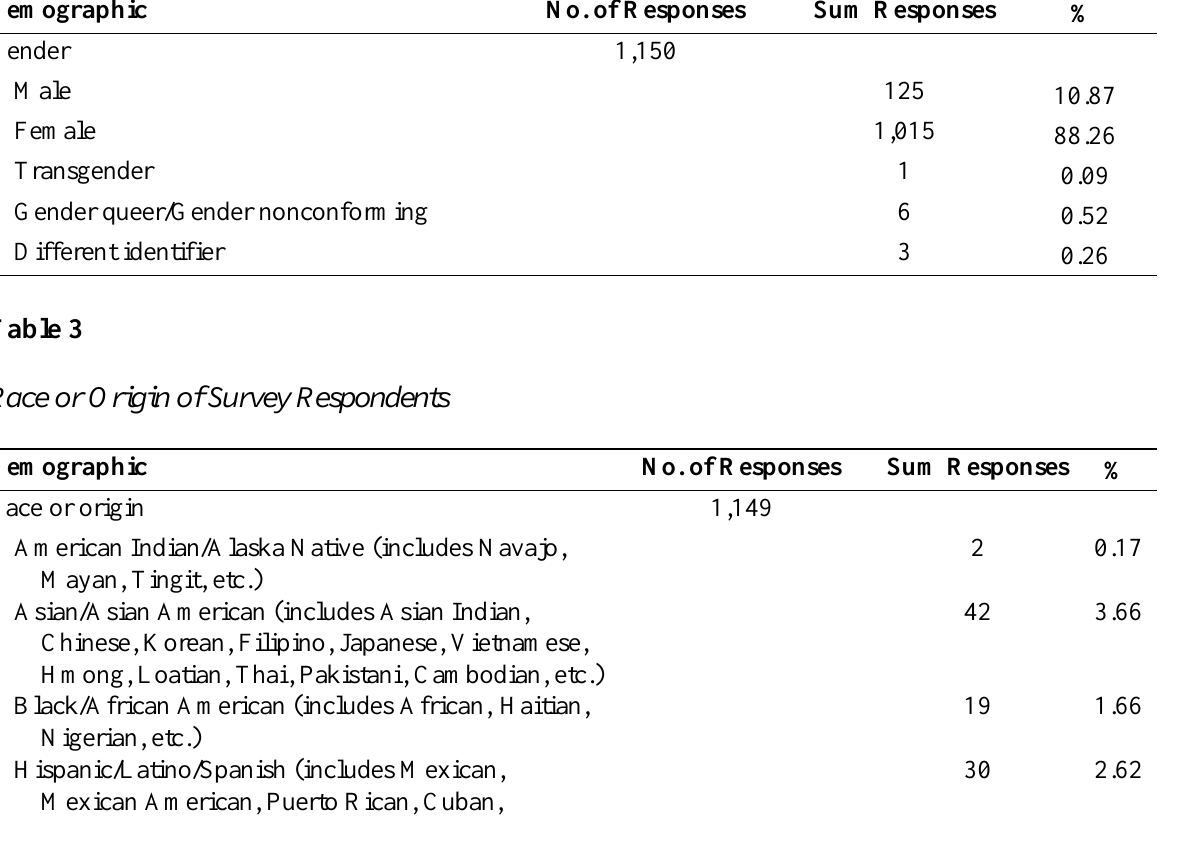
Gender/Gender Identity of Survey Respondents Demographic No. of Responses